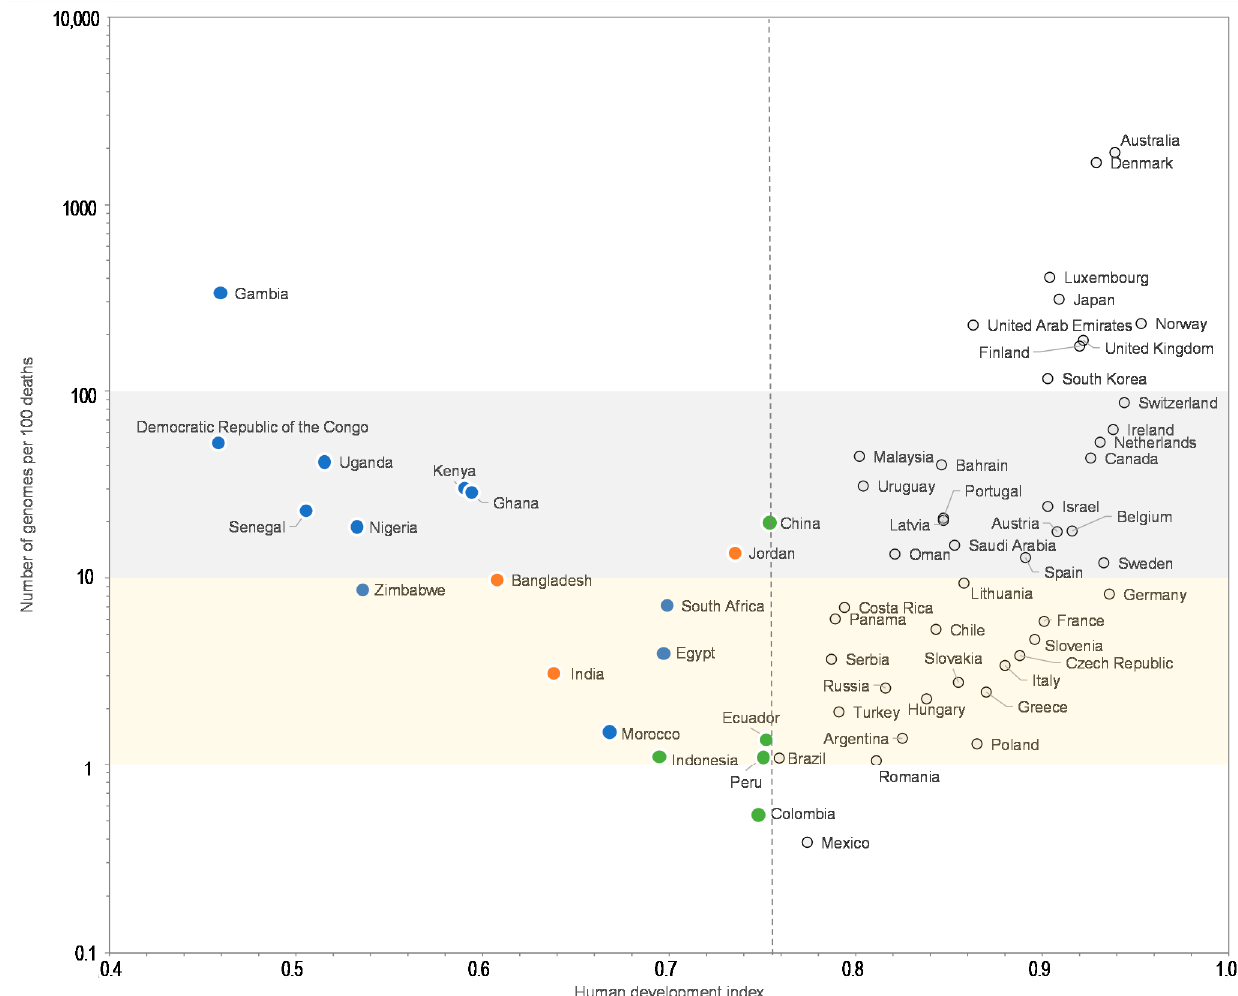
Figure 3. Number of SARS-CoV-2 genomes per 100 SARS-CoV-2-associated deaths vs. human development index. For a better legibility of the graph, only countries with more than 100 SARS-CoV-2 genomes are shown. Grey and yellow strips indicate countries with numbers of genomes per 100 deaths between 10 and 100, and between 1 and 10, respectively. Blue, green, and orange dots mark countries from Africa, America, and other regions, respectively, with a human development index below the mean value for all 135 countries studied here (0.756).